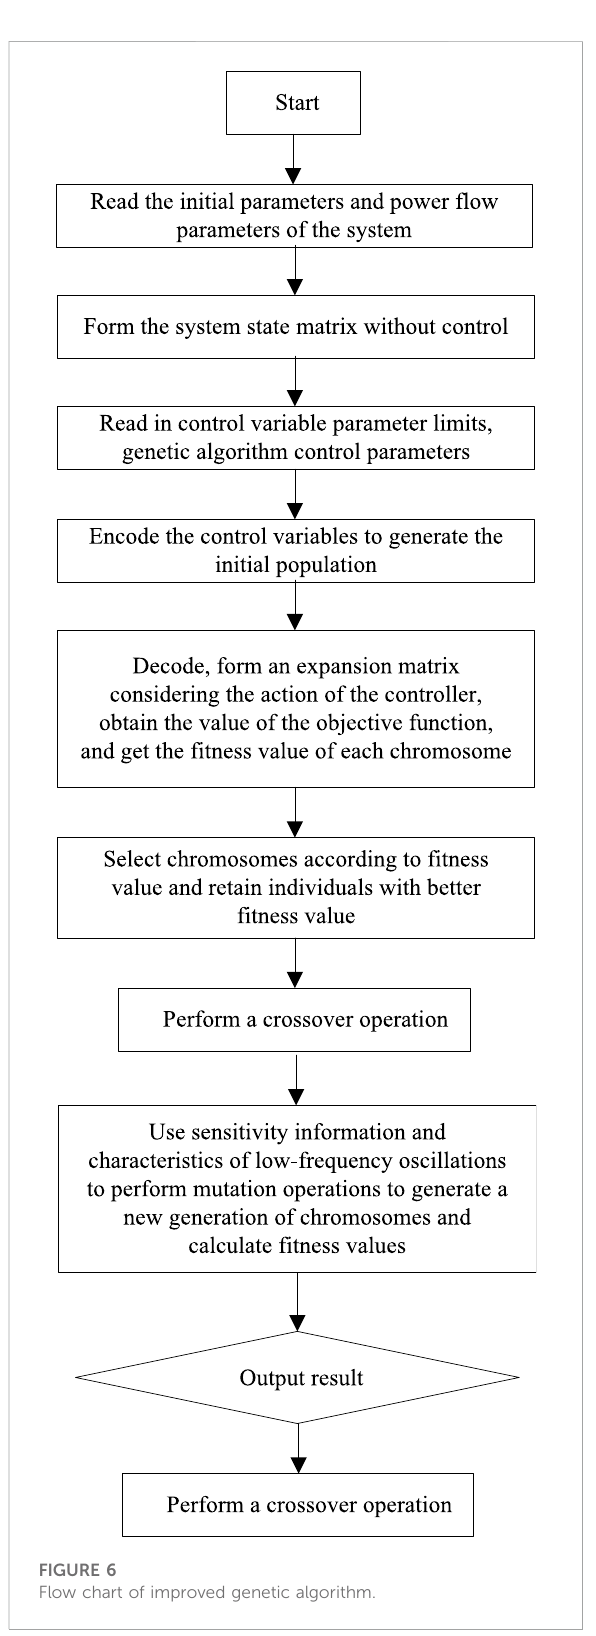
FIGURE 6 Flow chart of improved genetic